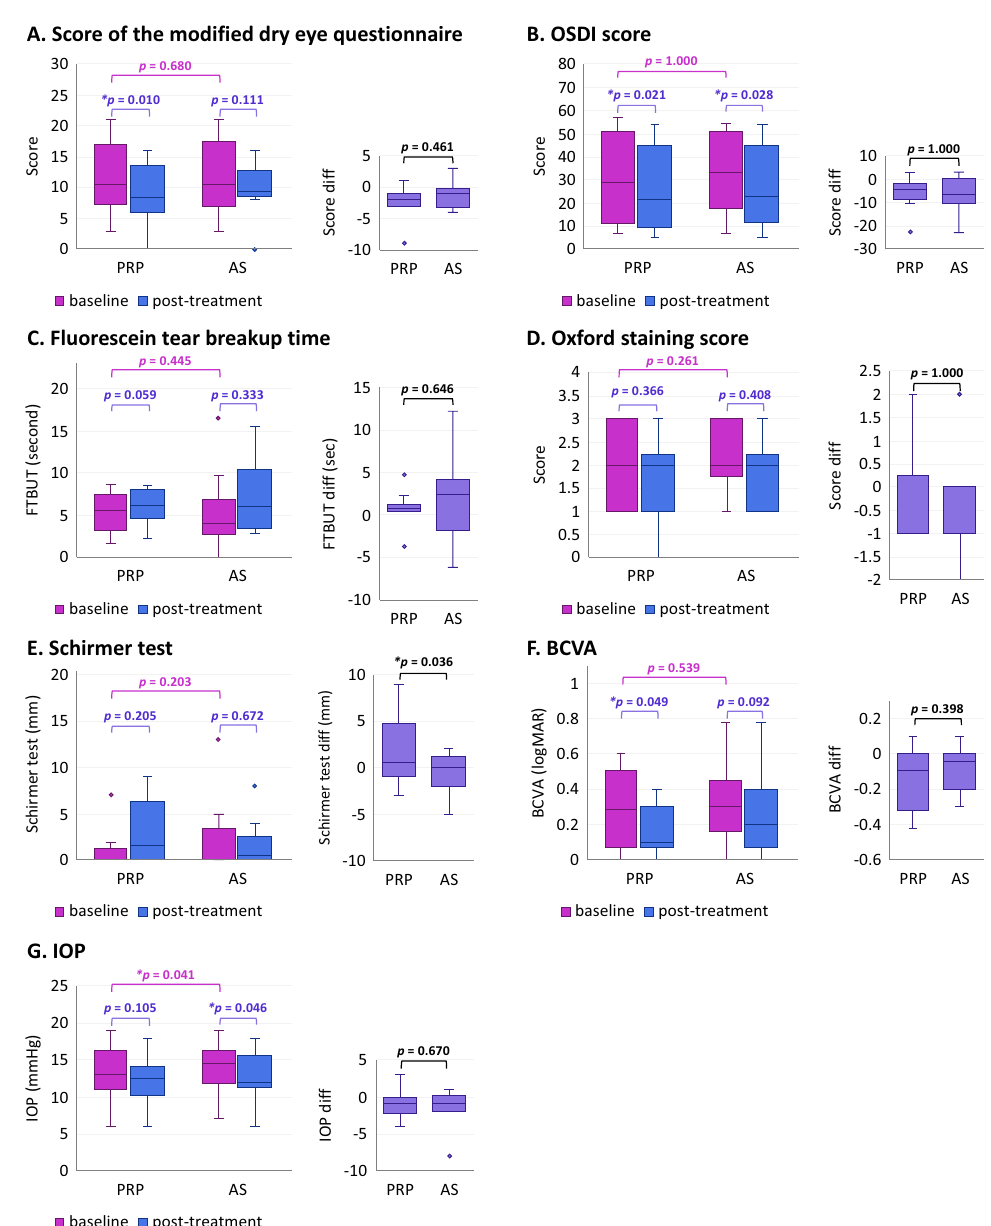
Figure 2. Characteristics of the patients at baseline and clinical outcomes. The patients were evaluated for their ( A ) score of the modified dry eye questionnaire, ( B ) OSDI score, ( C ) Fluorescein tear breakup time (second), ( D ) Oxford staining score, ( E ) Schirmer test (mm), ( F ) BCVA (LogMAR), and ( G ) IOP (mmHg). Median and interquartile range are shown in box plots (N = 10 for each group). The left panels of ( A–G ) show the values at baseline and clinical outcomes after treatment with PRP or AS; while the right panels of ( A–G ) show within- subject differences in scores or measurements after treatment. * p -values designate those that are statistically significant; p -values (without *) designate those that are not statistically significant, as analyzed by Wilcoxon signed rank